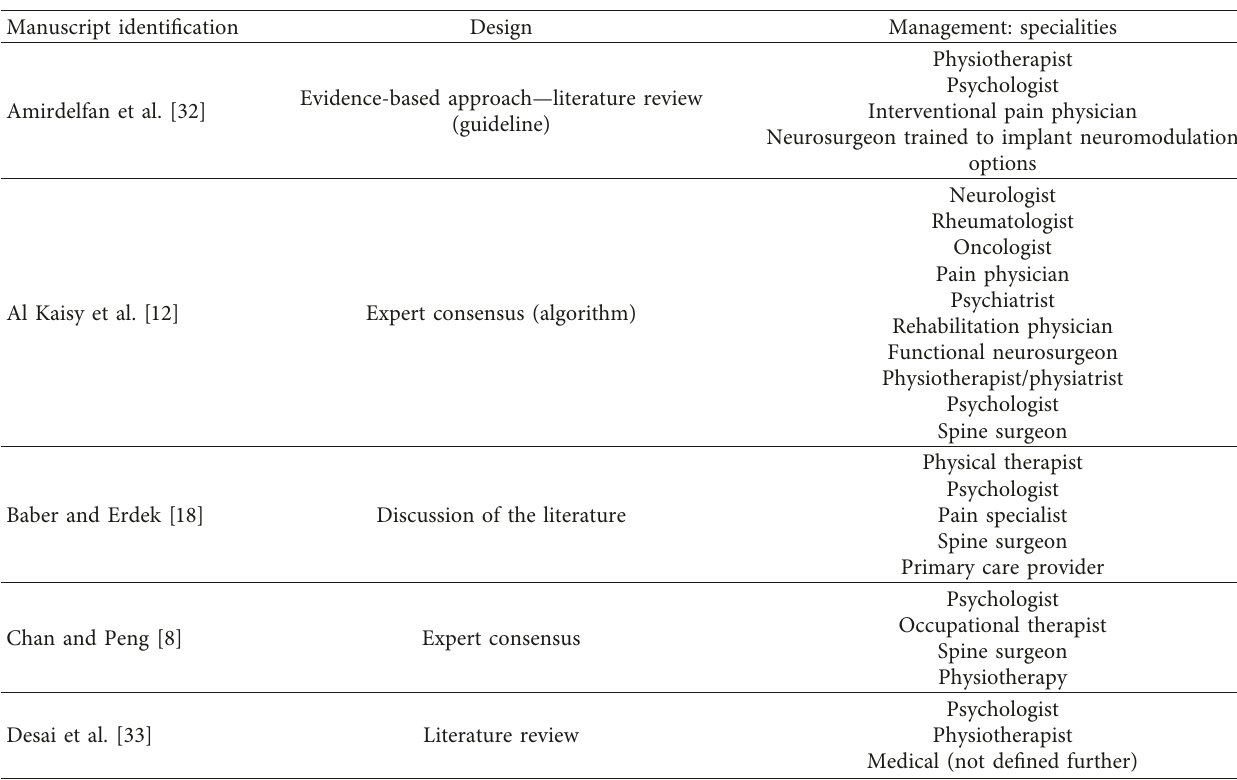
Figure 1: Schematic diagram of steps in the literatures searches: FBSS definition and evaluation. The electronic and hand literature searches yielded 1663 titles and 74 textbooks. Following a review of full-text versions of the 363 residual publications, after discarding duplicates and initial exclusion of 1300 titles/abstracts, 108 papers were finally selected, and 12 were retained for FBSS definition and MDTassessment and composition (Supplementary Material 1). Table 1: Output of the review of publications with recommendations for specialties to be included in the multidisciplinary team management of failed back surgery